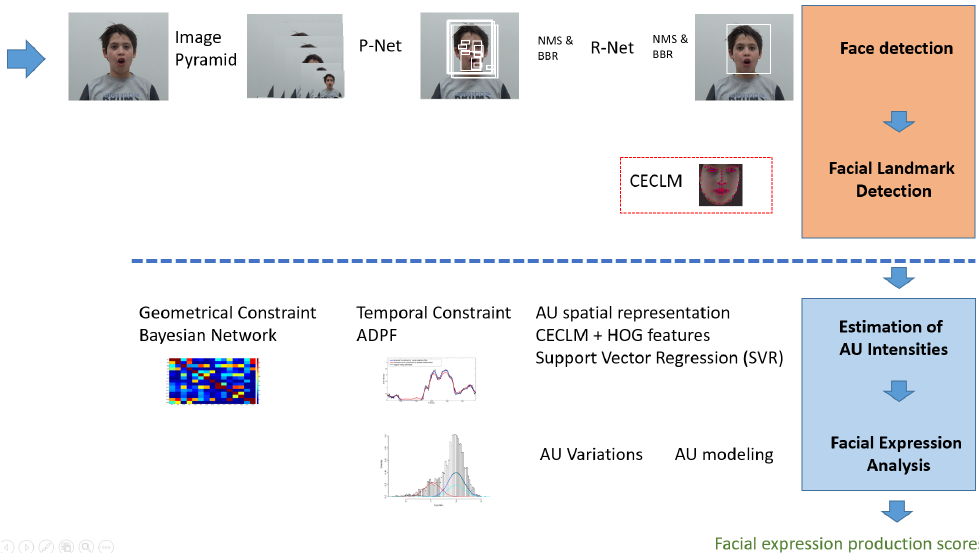
Figure 1. The proposed algorithmic pipeline. The figure points out, by the horizontal dotted line and the blocks differently colored, that the two modules (face detection and facial landmark detection and tracking) above the dotted line (colored in light orange) are the ones heavily improved with regards to the former work in